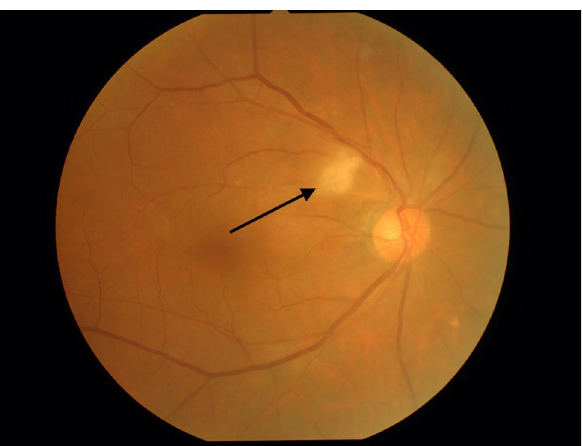
Figure 1. Ophthalmological manifestations 13 days after acute myocardial infarction (AMI). A 77-year-old male was diagnosed with AMI and underwent direct angioplasty 3.5 h after the first episode of severe chest pain. A cotton wool spot (arrow) appeared adjacent to the right optic disc 13 days after AMI. The patient visual acuity was 20/20, and there were no ocular symptoms. The mean ocular blur rate, resistivity index, and blowout time, parameters assessed by laser speckle flowgraphy, were 13.7, 0.58, and 44.1,